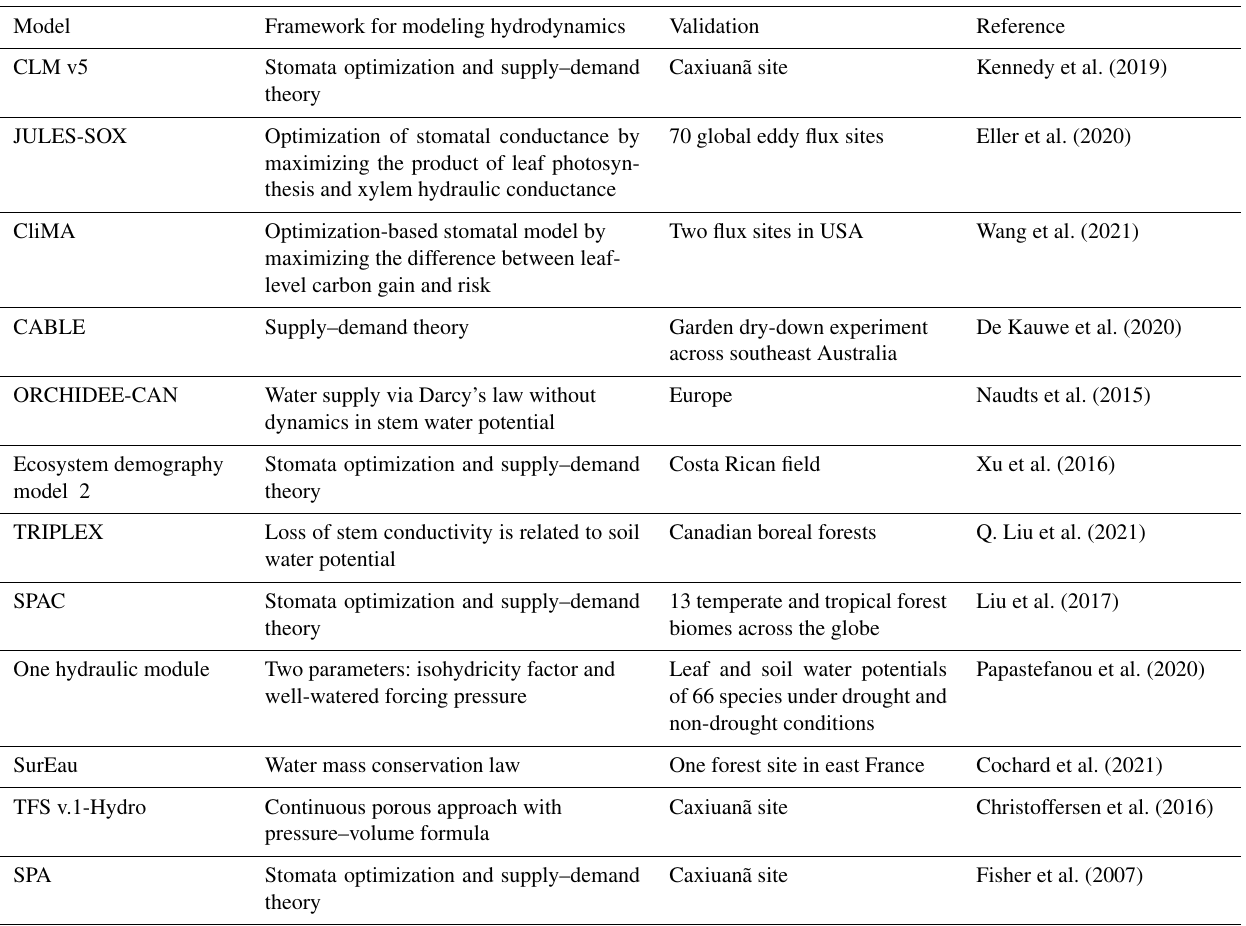
Table A1. Plant hydraulics in major vegetation models. The column of validation indicates how the model performance is validated against